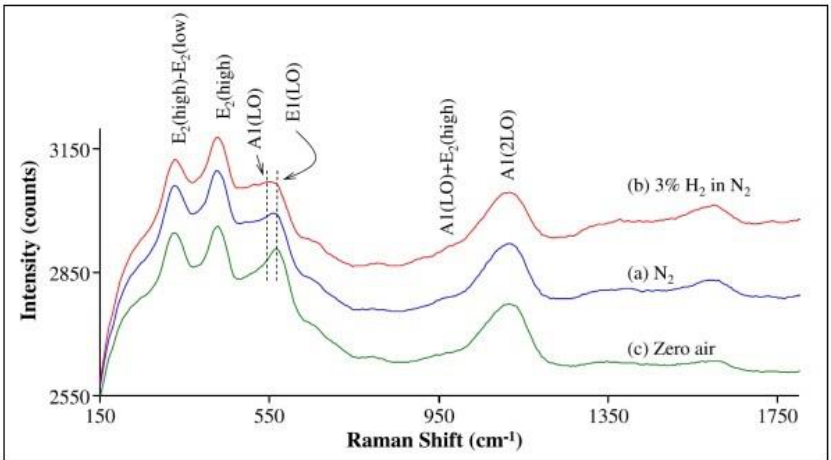
Figure 6. In situ Raman spectra of ZnO (sample A) in (a) N 2 , (b) 3% H 2 in N 2 , and (c) zero air. The spectra are offset or clarity. Modified from [30].